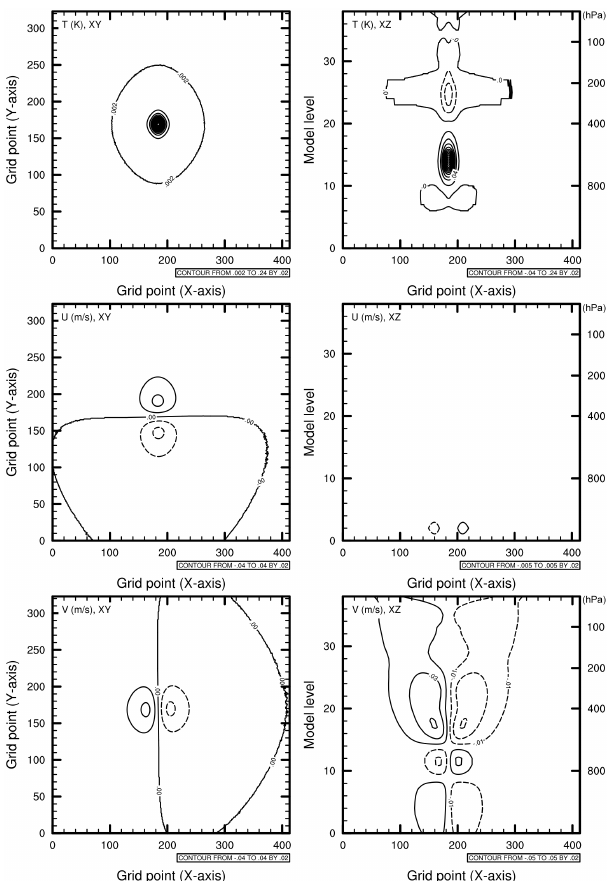
Figure 12. Pseudo observation test of temperature (innovation of + 1K) from the GSI application. The three plots in the left panel show, from top to bottom, horizontal cross sections ( XY ) of the t (K), U and V wind components (ms − 1 ) , respectively. Then, the right panel shows the corresponding cross section ( XZ ) of the for- mer variables ( B rcf : WRF, res. 15km, D-ensemble,